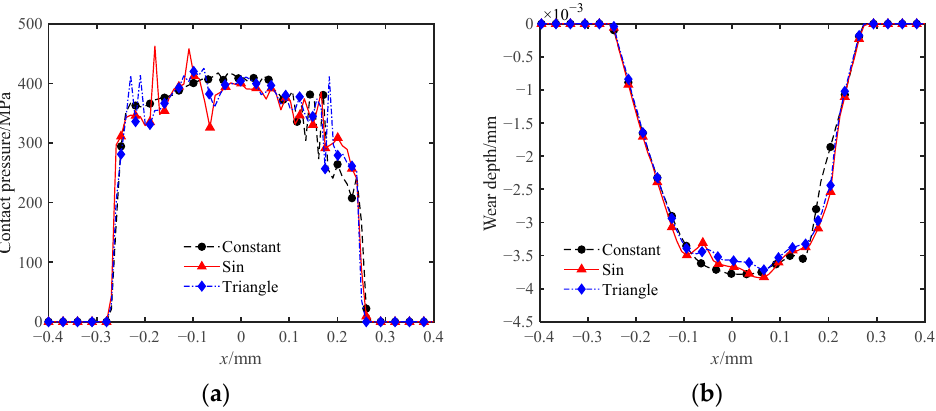
Figure 13. Variation of contact pressure and wear depth with normal load. ( a ) Contact pressure; ( b ) wear depth.